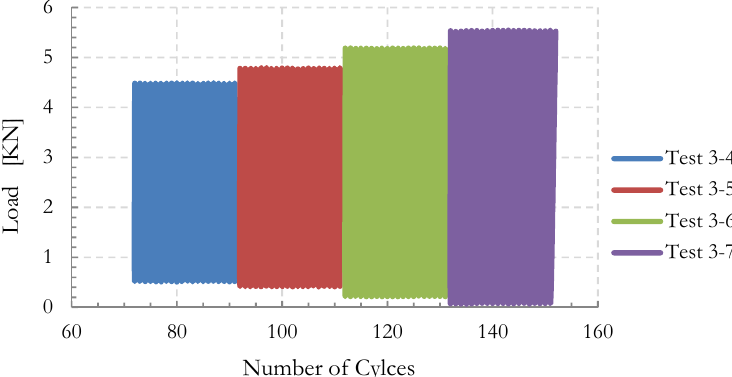
Figure 1: The cyclic loading scheme used for the